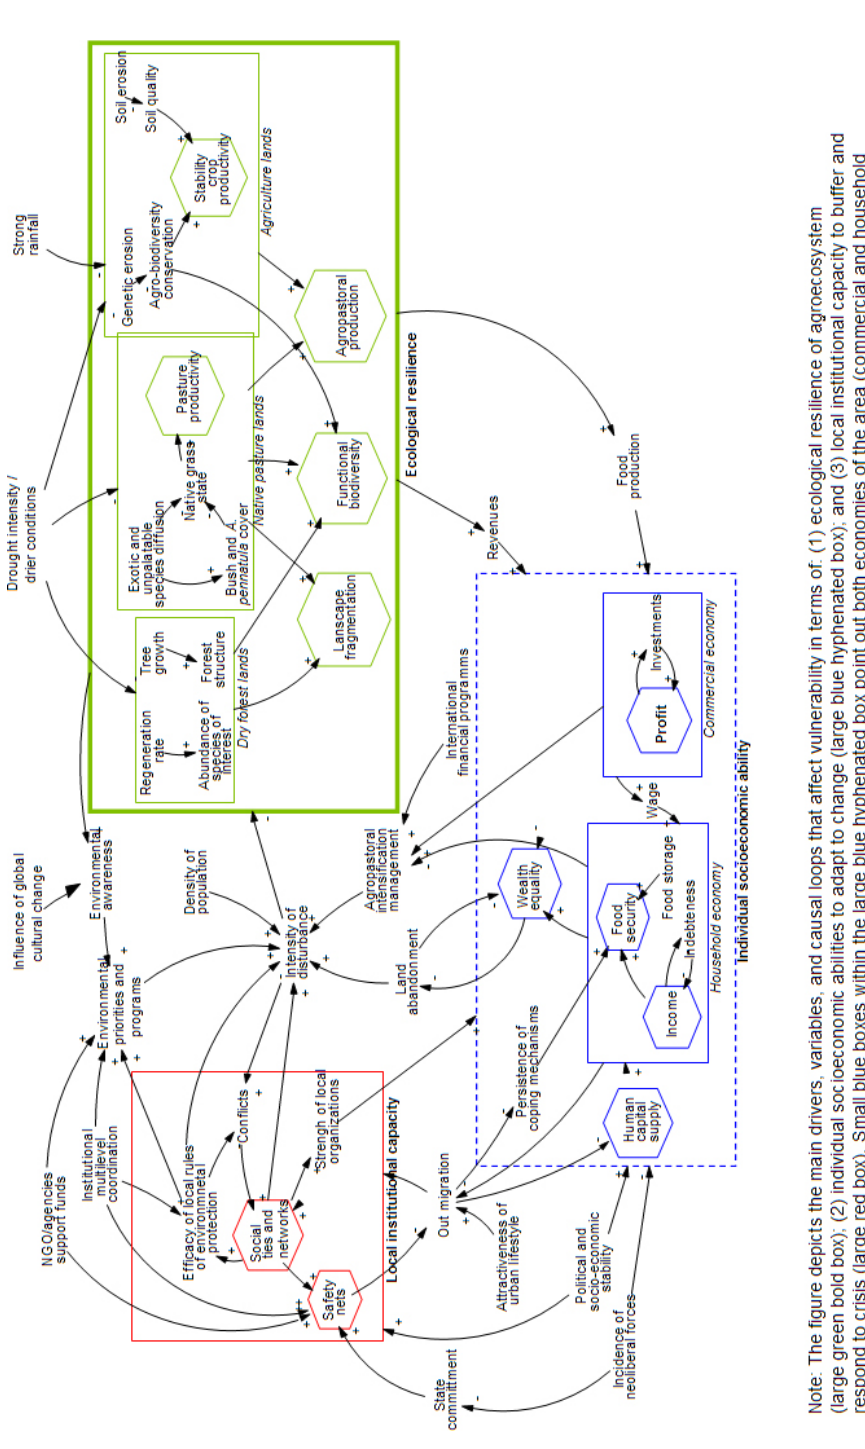
Fig. 3. Overall conceptual model of the agropastoral